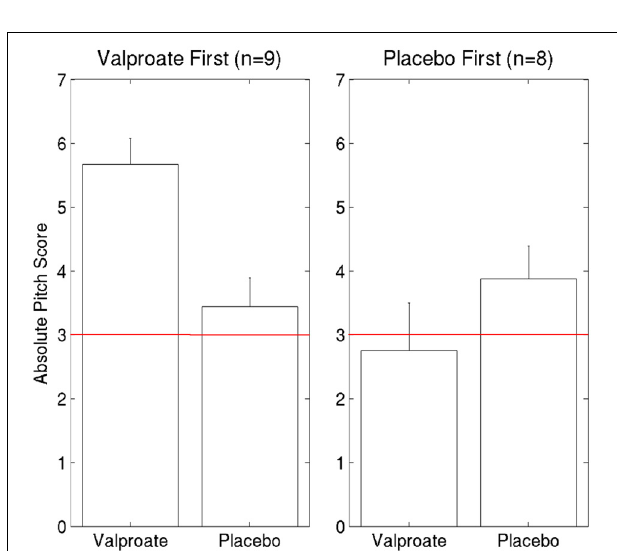
FIGURE 4 | Comparing the effects of VPA and placebo for each treatment order. The red line indicates chance